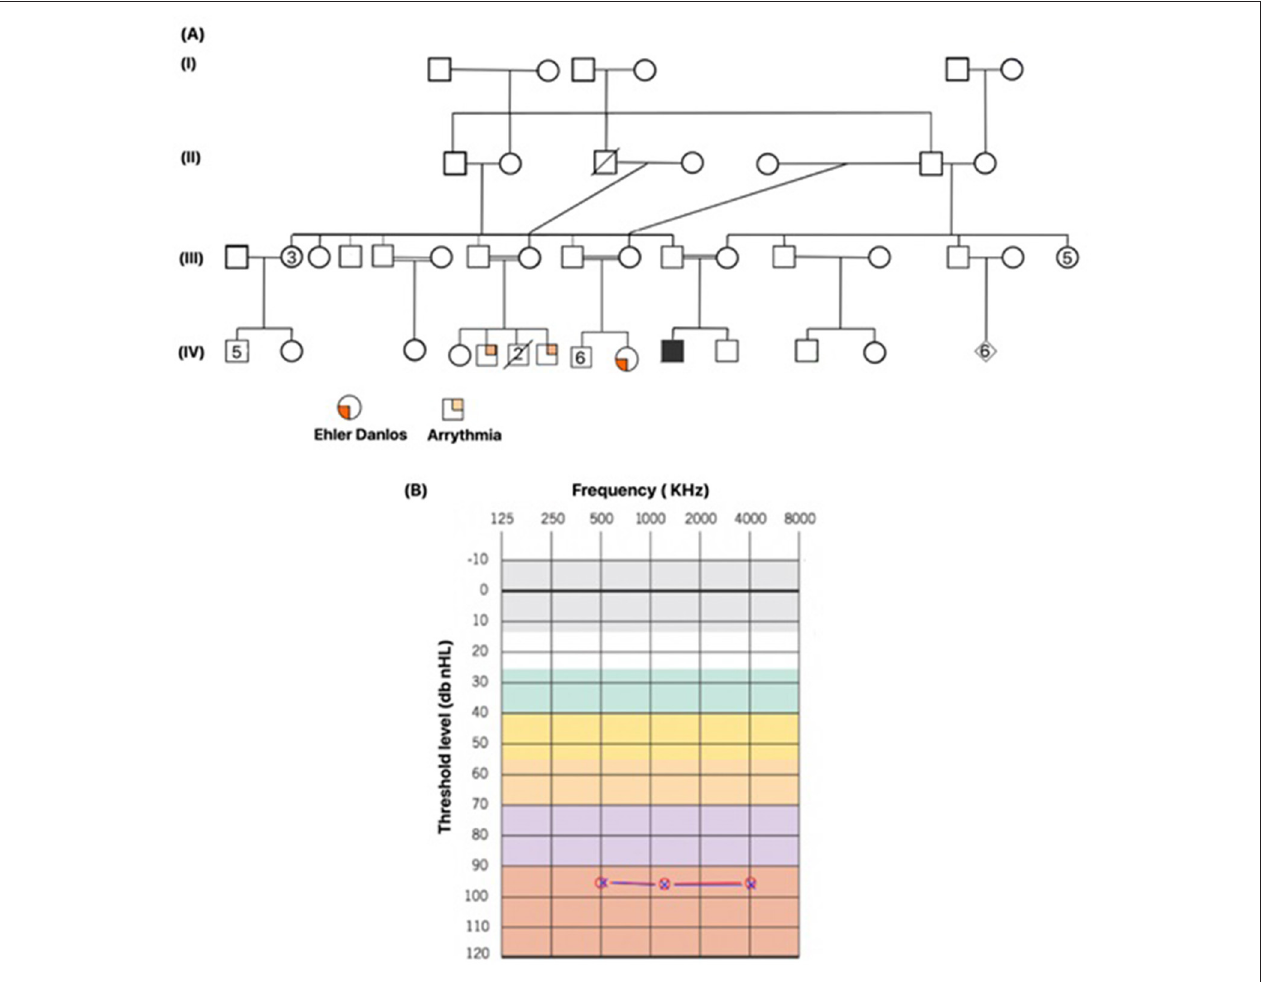
FIGURE 1 | The affected patient’s family pedigree and the results of a confirmatory hearing loss test. (A) Family pedigree of the index patient, showing a highly inbred family. Family has a history of Ehler Danlos syndrome and history of cardiac arrythmia. The index patient is indicated with filled square. Male and female are shown in squares and circles, respectively. (B) Threshold test indicating the level of hearing loss recorded from the auditory brainstem response (ABR), classifying it to be severe. Background colors represent the severity of hearing loss. Normal hearing (gray and white), mild hearing loss (green), moderate hearing loss (yellow), moderately severe hearing loss (orange), severe hearing loss (purple), and profound hearing loss (red). Measurements were recorded in both ears at three frequencies. Red circle indicates the value recorded in left ear, blue cross in a red circle indicates the value recorded in right